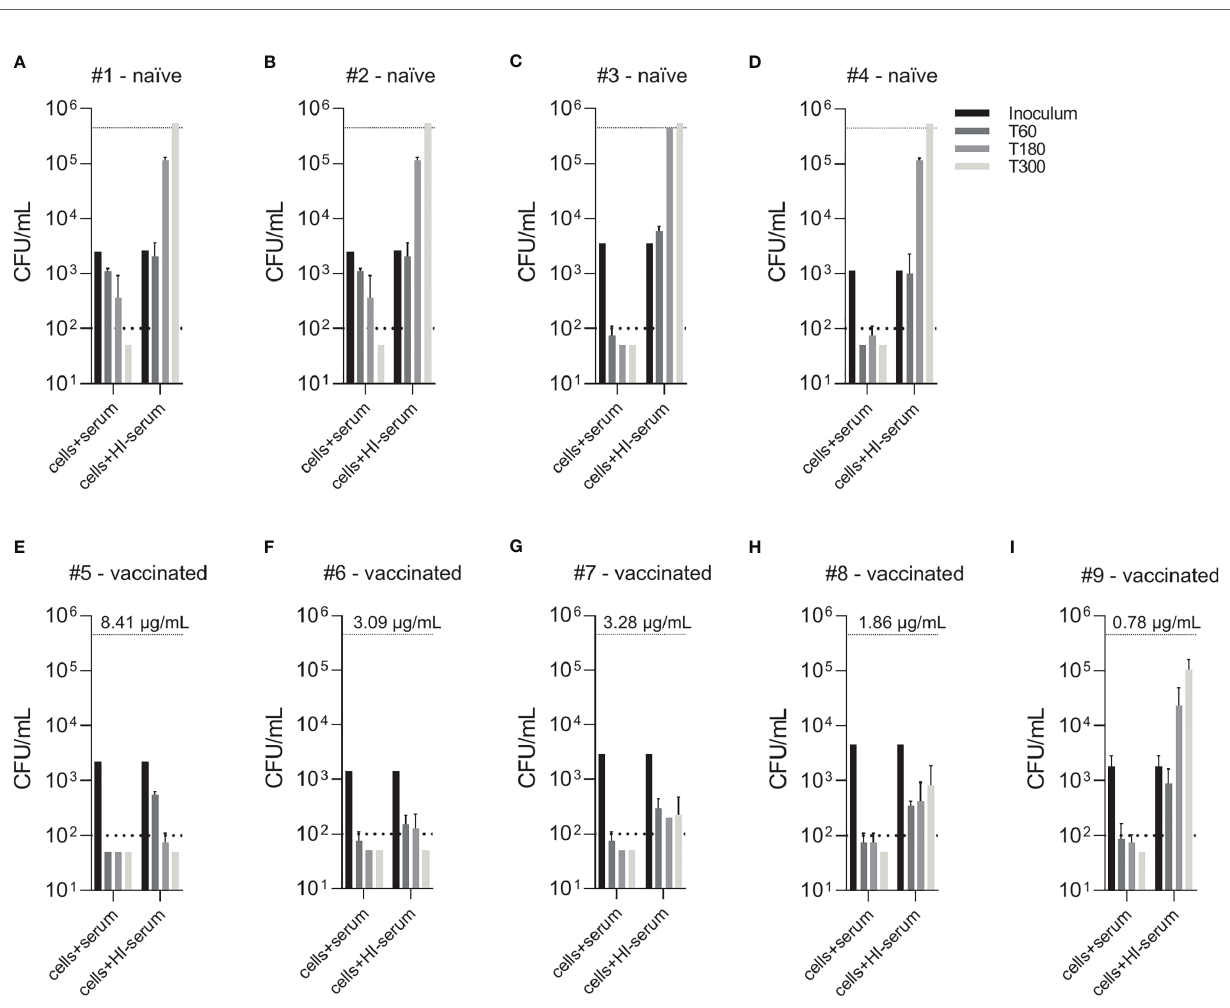
FIGURE 4 | Effect of vaccine-induced anti-pneumococcal capsule antibodies in the absence of active complement. Pneumococcal killing was assessed in an opsonophagocytosis assay based on DPBS-washed cells from EDTA-anticoagulated blood reconstituted with active or HI serum, comparing individual vaccine-naïve (A – D) and PCV13-vaccinated individuals (E – I) . Concentration of serotype 4 capsule polysaccharide-speci fi c IgG in sera of vaccinated subjects is displayed. Bars indicate CFU/mL at time of bacterial inoculation and after 60, 180 and 300 minutes. Dashed lines demonstrate the lower detection limit ( < 100 CFU/mL) and the upper limit ( > 500 ’ 000 CFU/mL) for exact quanti fi